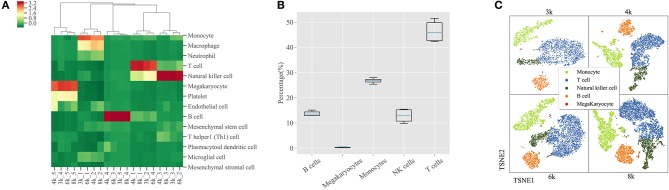
Cell components of PBMCs predicted by SCSA. (A) Clustering of uniform scores of the top five predicted cell types in four PBMCs datasets by SCSA. Each column stands for one cluster of four PBMCs datasets and each row stands for one cell type. Uniform scores were normalized using the z-score method to make clusters comparable. (B) Percentages of four different cell types in four PBMCs datasets based on SCSA's prediction. (C) Five cell types plotted by t-SNE based on the prediction of SCSA for four PBMCs datasets.